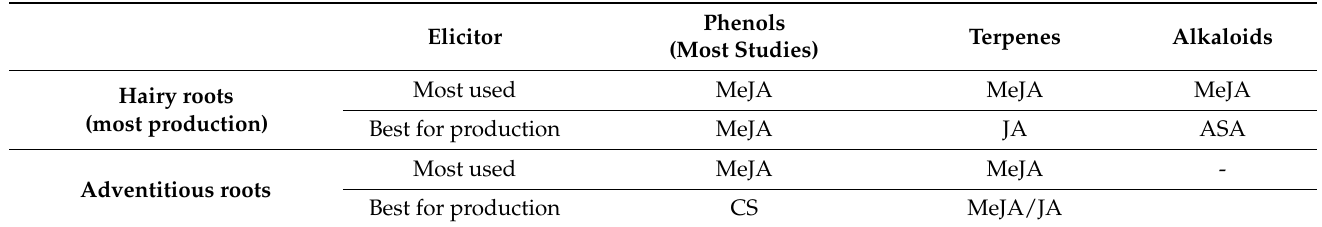
Table 6. Summary of the most frequently used elicitors and those that produce the best results for each group of secondary metabolites (from 2010 to 2022).